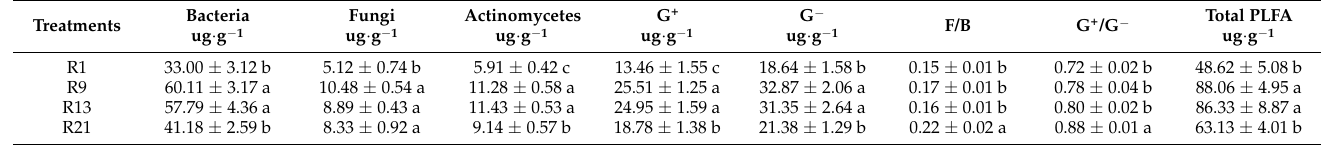
Table 5. Changes of soil percentage of phospholipid fatty acids after long-term continuous cropping.